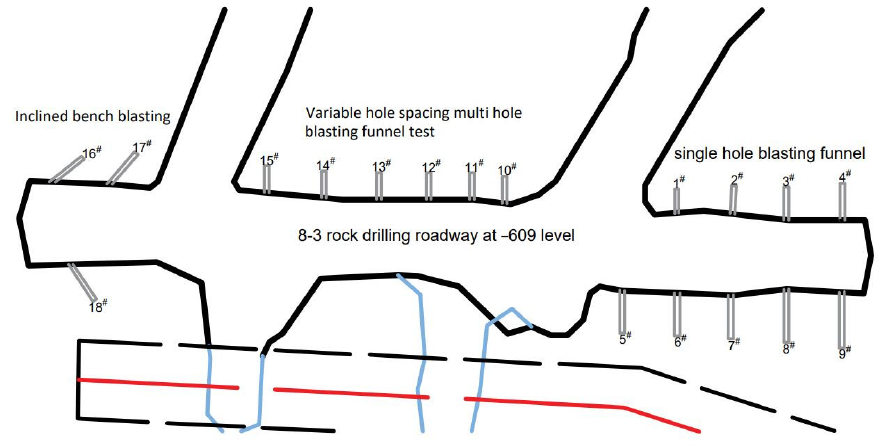
Figure 1. Plane layout of blast holes for series blasting funnel test. (In the figure, ‘ # ’ is for the convenience of numbering the holes, 1 # represents hole number one, and so on )